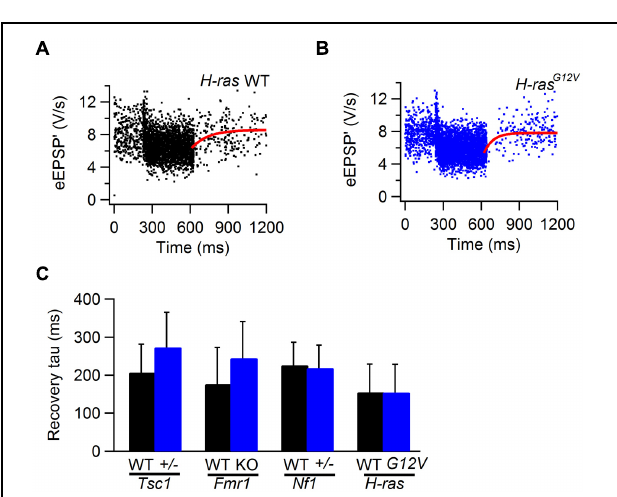
FIGURE 7 | Recovery from STD in WT and Tsc1 + / − , Fmr1 KO, Nf1 + / − , and H-ras G 12 V mutant mice. (A) Sound-evoked eEPSP’ in WT animal. Solid line (red) is fit of recovery from sound-evoked STD with single exponential function with time constant of 127 ms. (B) As (A) , except the recording is from a H-ras G 12 V animal. Fit time constant was 159 ms. (C) Comparison of the recovery time constants from WT (black) and Tsc1 + / − , Fmr1 KO, Nf1 + / − , and H-ras G 12 V mutants. Error bars indicate